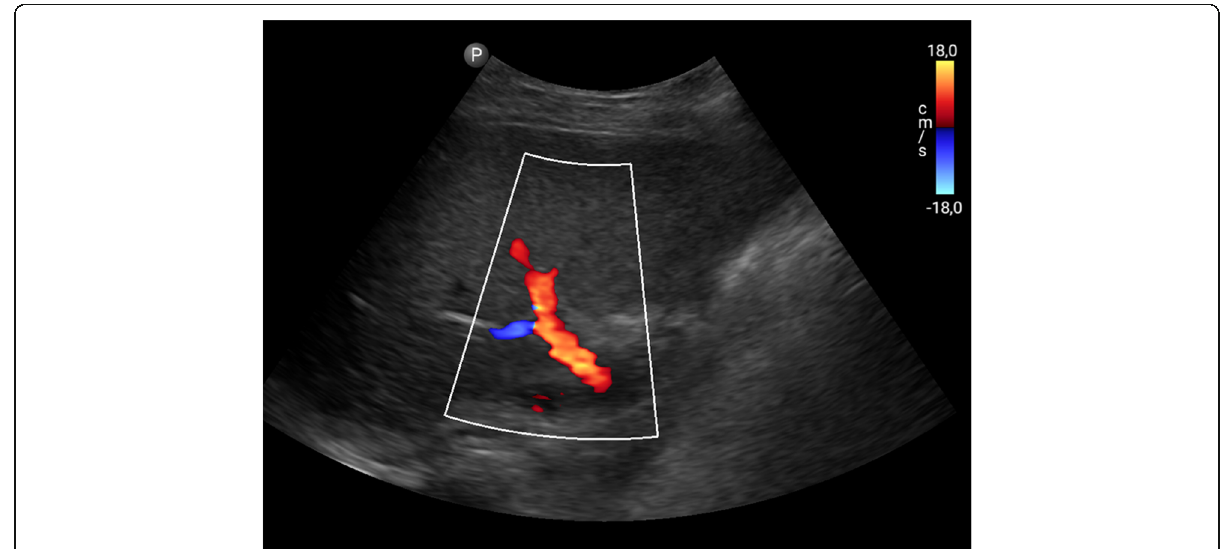
Fig. 7 Philips Lumify curved array transducer: Colour Doppler imaging of the portal